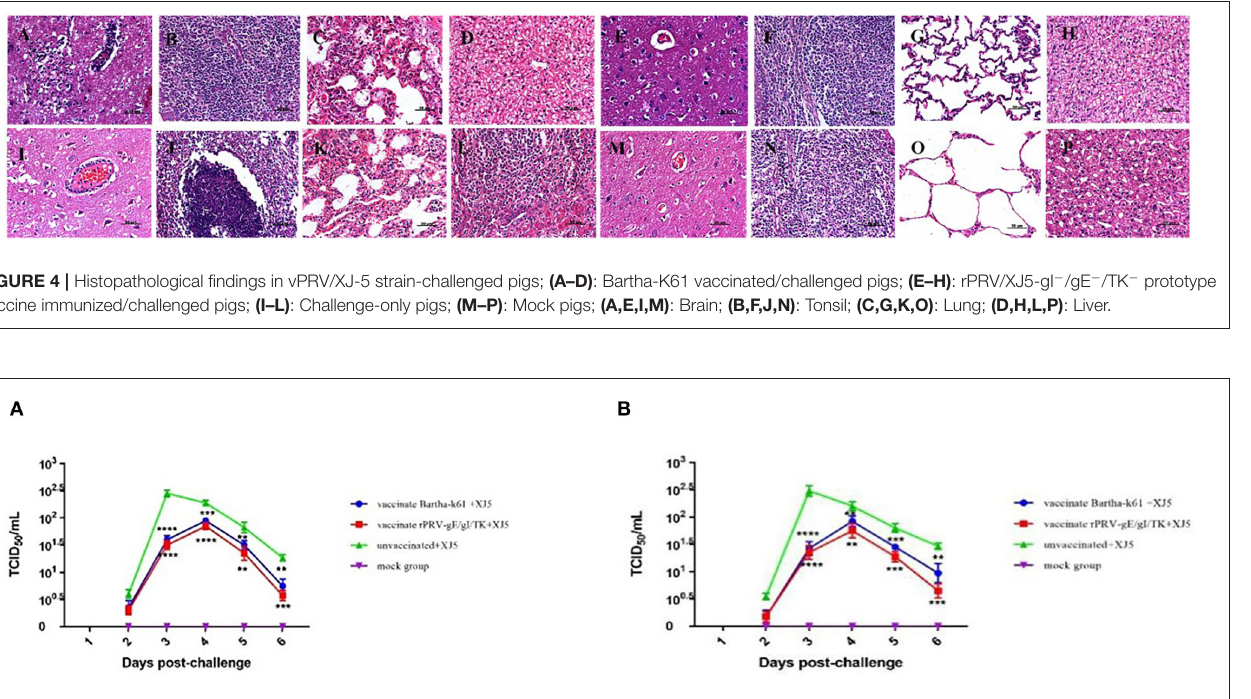
FIGURE 5 | TCID 50 of PRV in swabs from pigs in each group after challenge; (A) TCID 50 of PRV in oropharyngeal swabs; (B) TCID 50 of PRV in rectal swabs; (error bars represent standard errors of the mean of each group all replicates); ** p < 0.01, *** p < 0.001 and **** p < 0.0001 compared with challenge-only